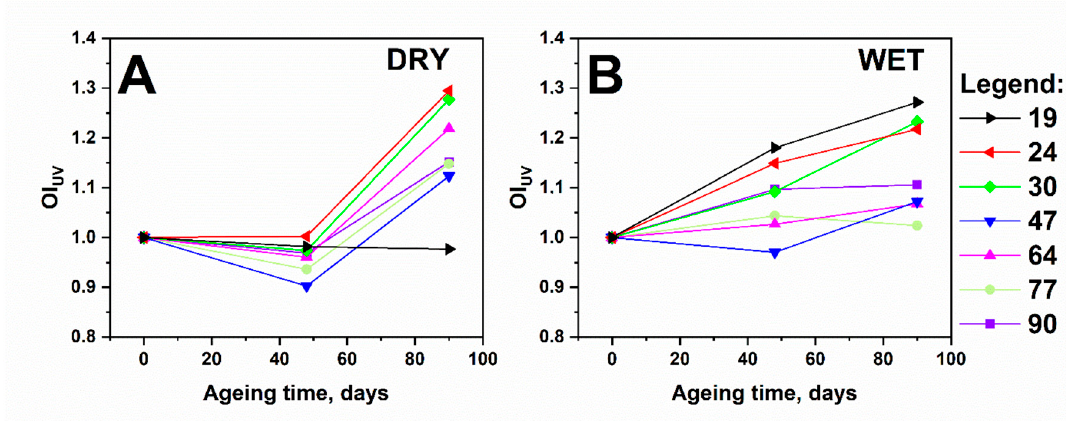
Figure 4. UV–Vis reflectance spectra of paper samples with different Kappa numbers, aged under different ageing conditions: ( A ) dry atmosphere and ( B ) humid atmosphere.